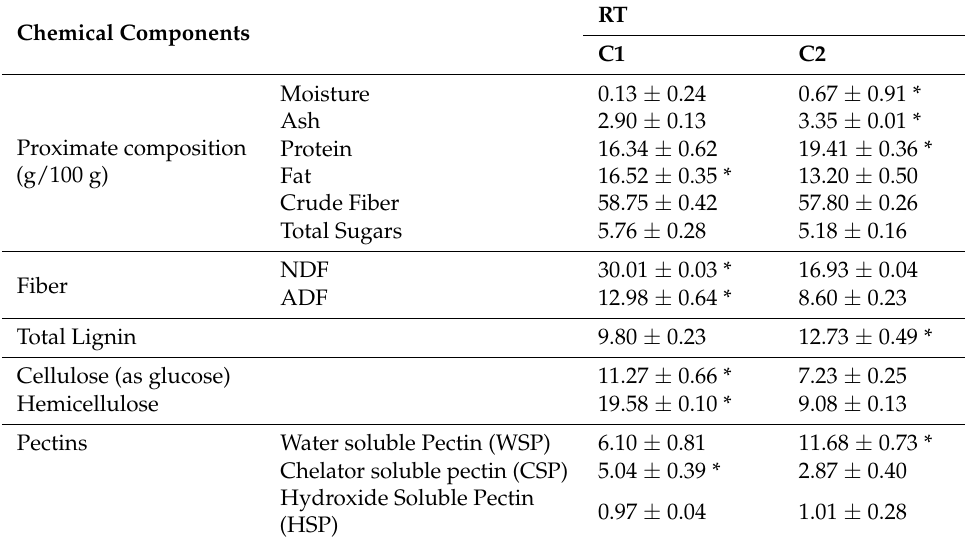
Table 1. Proximal composition of tomato